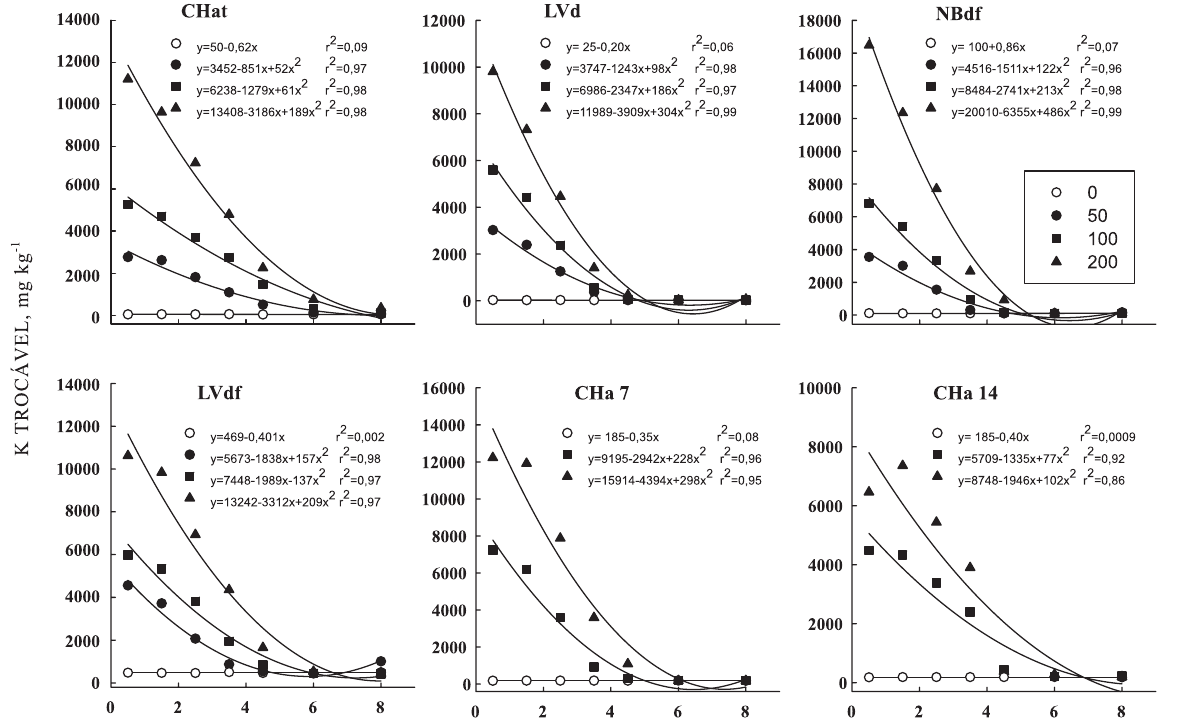
Figura 1. Teores de K trocável nos solos em diferentes distâncias a partir da região fertilizada com doses de K O (kg ha -1 ) na forma de KCl. Média de quatro repetições. CHa: Cambissolo Húmico Alumínico léptico; 2 CHat: Cambissolo Húmico Alumínico típico; NBdf: Nitossolo Bruno Distroférrico típico; LVdf: Latossolo Vermelho distroférrico; LVd: Latossolo Vermelho distrófico. No CHat, não foi utilizada a menor dose (50 kg ha -1 de K 2